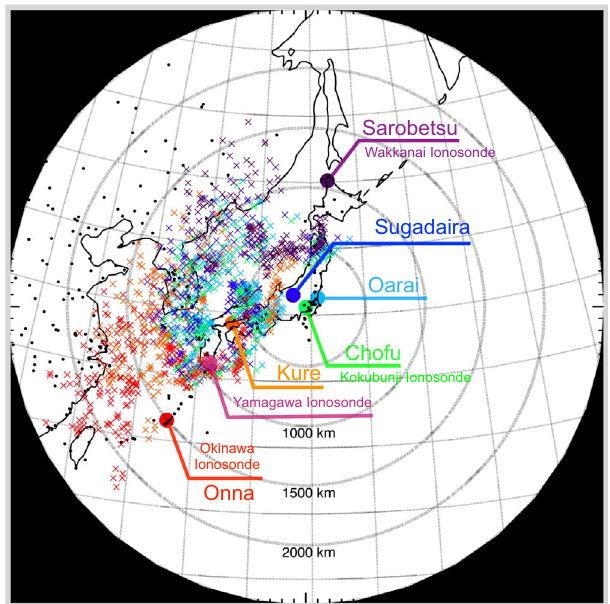
Fig. 1. Map of six Rx stations (Sarobetsu, Sugadaira, Oarai, Chofu, Kure and Onna), VOR Tx stations (black dots) and the Es propagation zone centered at Chofu, Tokyo. All the possible re fl ection points (i.e., mid-points between the Tx and Rx stations) are shown by the colored crosses (purple = Sarobetsu, light blue = Oarai, green = Chofu, blue = Sugadaira, orange = Kure, and red = Onna). The locations of the four ionosonde stations in Japan are also